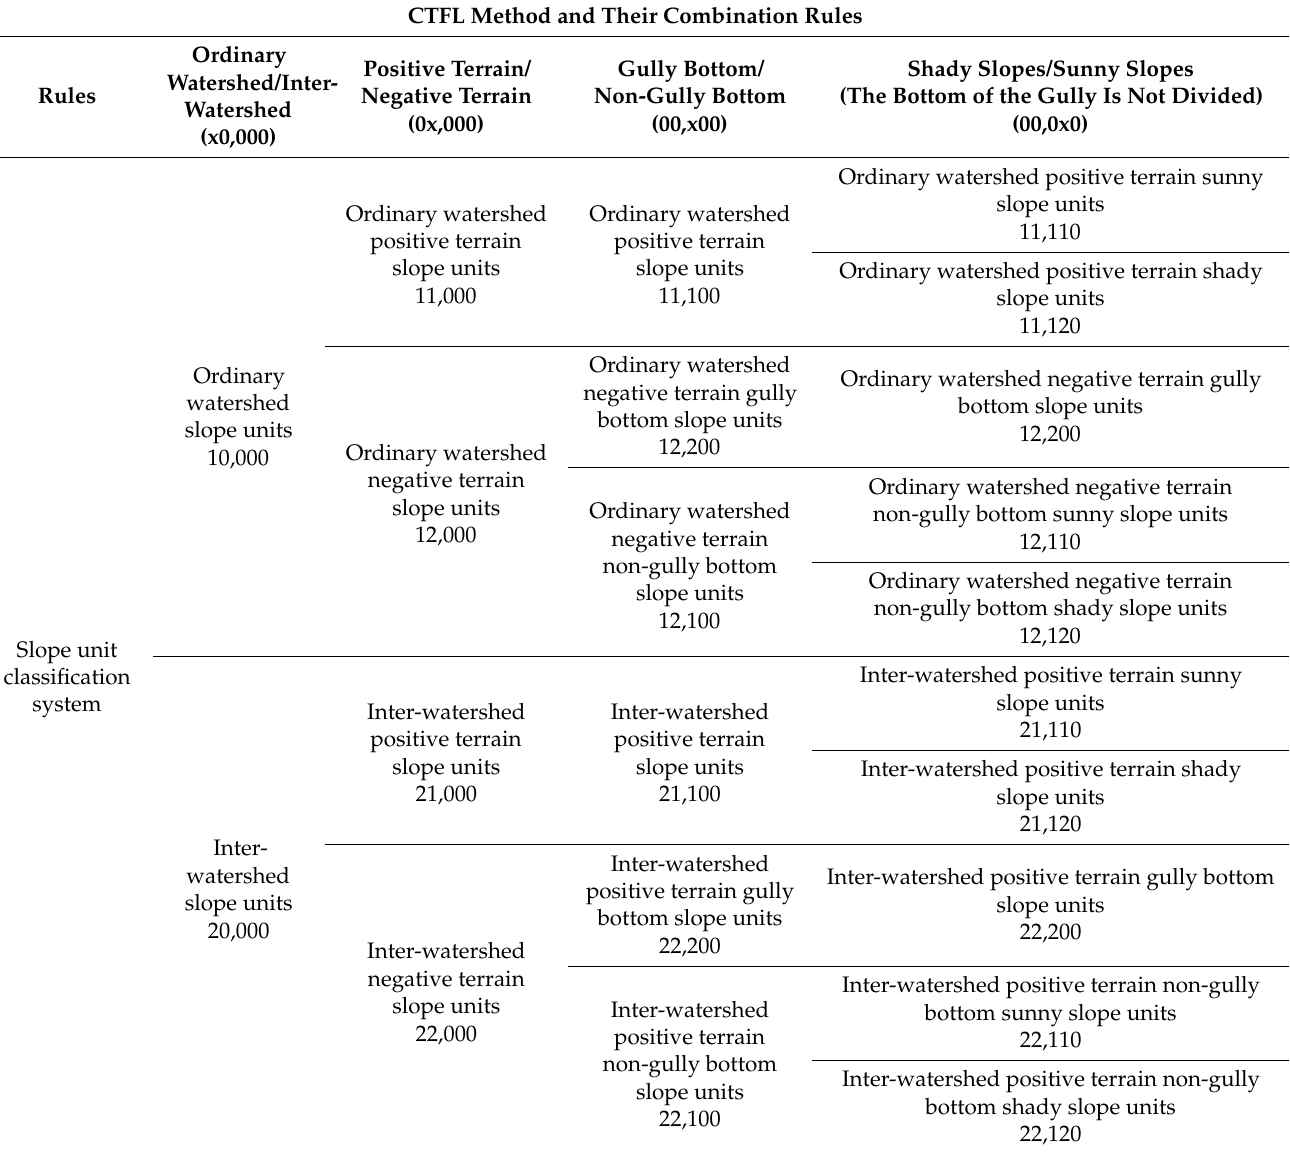
Table 2. The combination rules of the CTFL